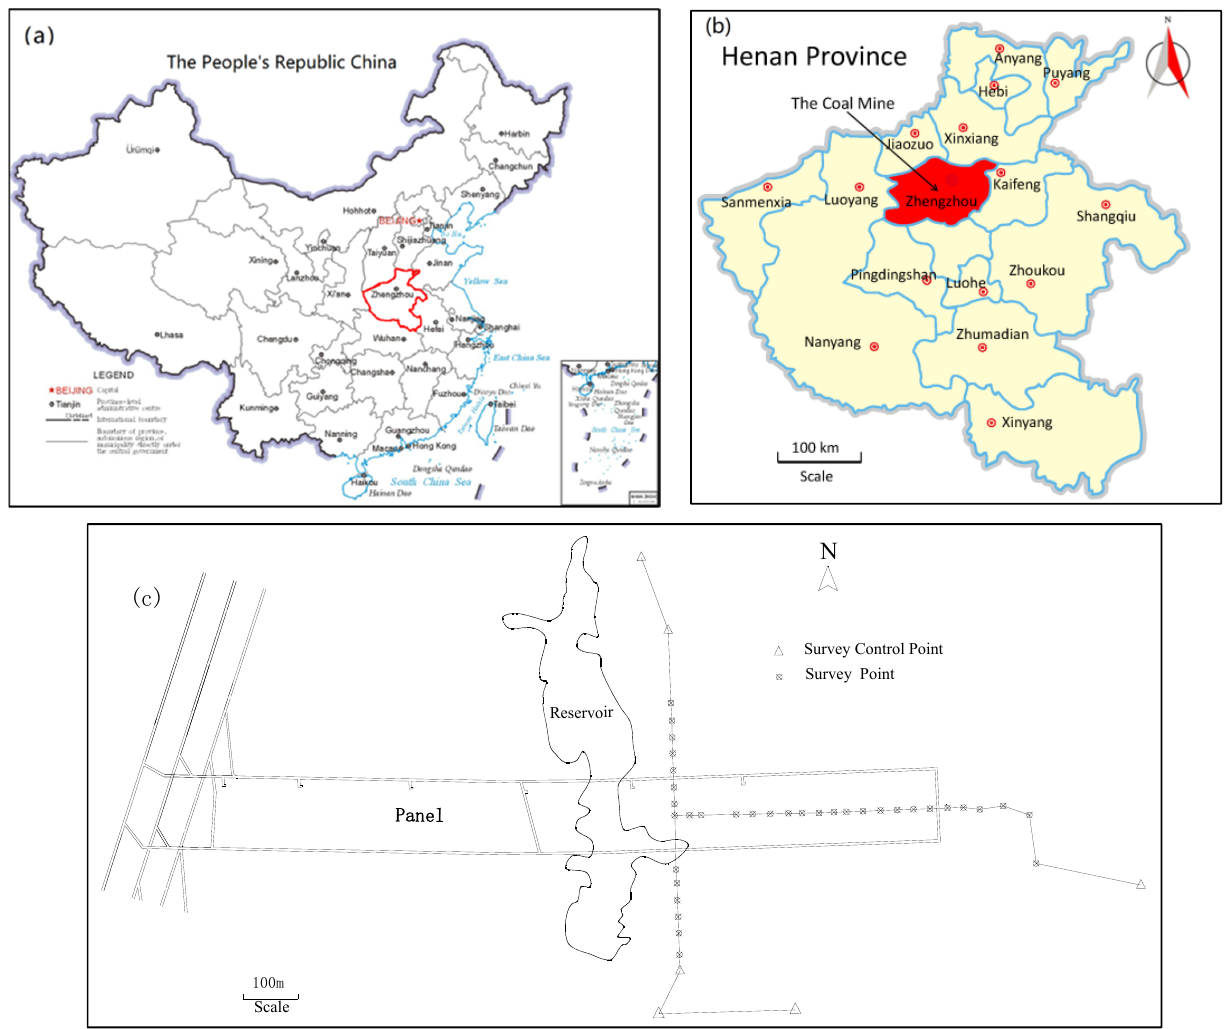
Figure 2. Location of survey lines, ( a ) map of the People’s Republic of China, ( b ) location of the Peigou Coal Mine, ( c ) position relationship between the panel and survey lines.